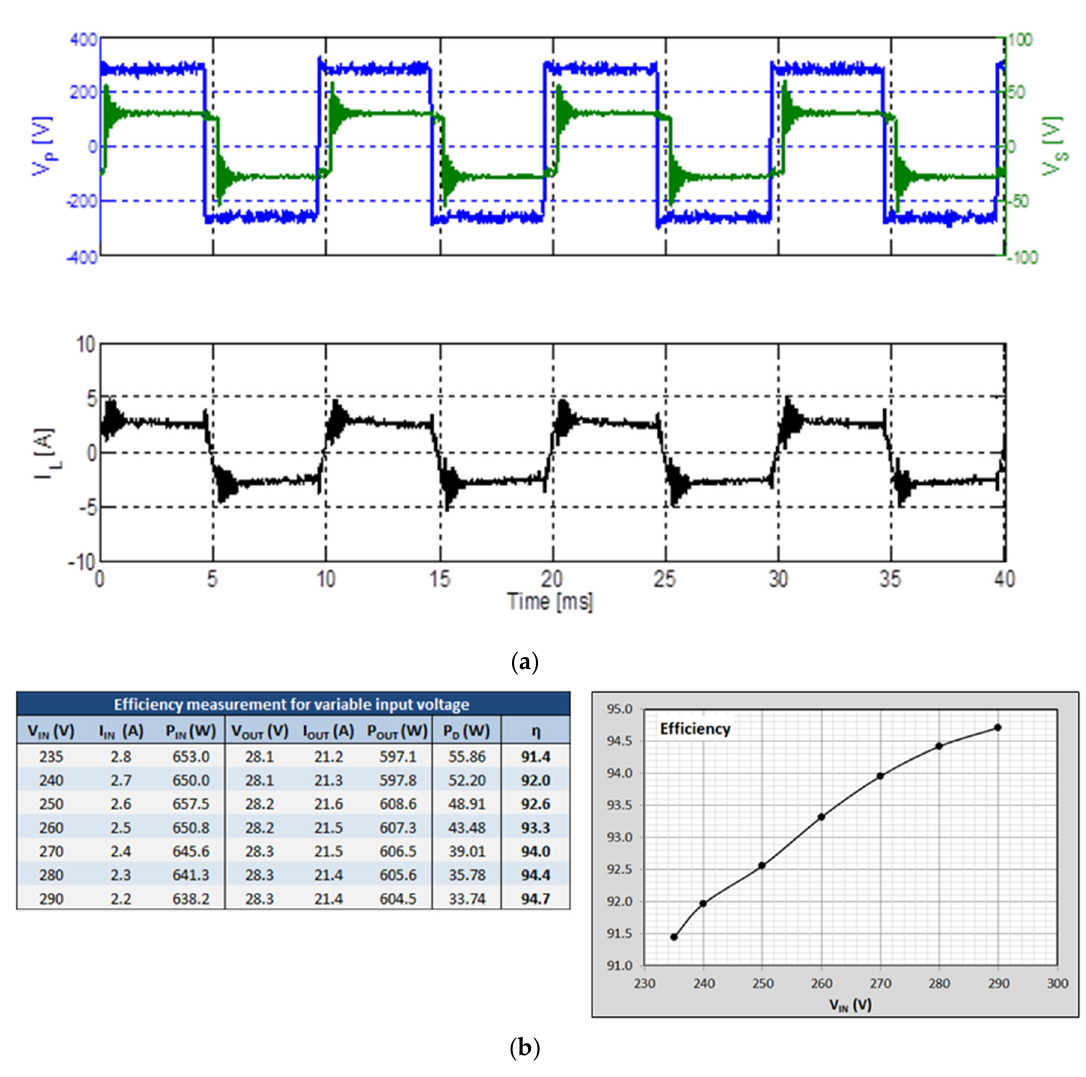
Figure 9. Photographs of developed hardware: single DC-DC converter cell ( a ); view of cased converter Energies 2019 , 12 , x FOR PEER REVIEW and control board, with details of wiring, and connectors ( b ); external view of cased unit ( c ).